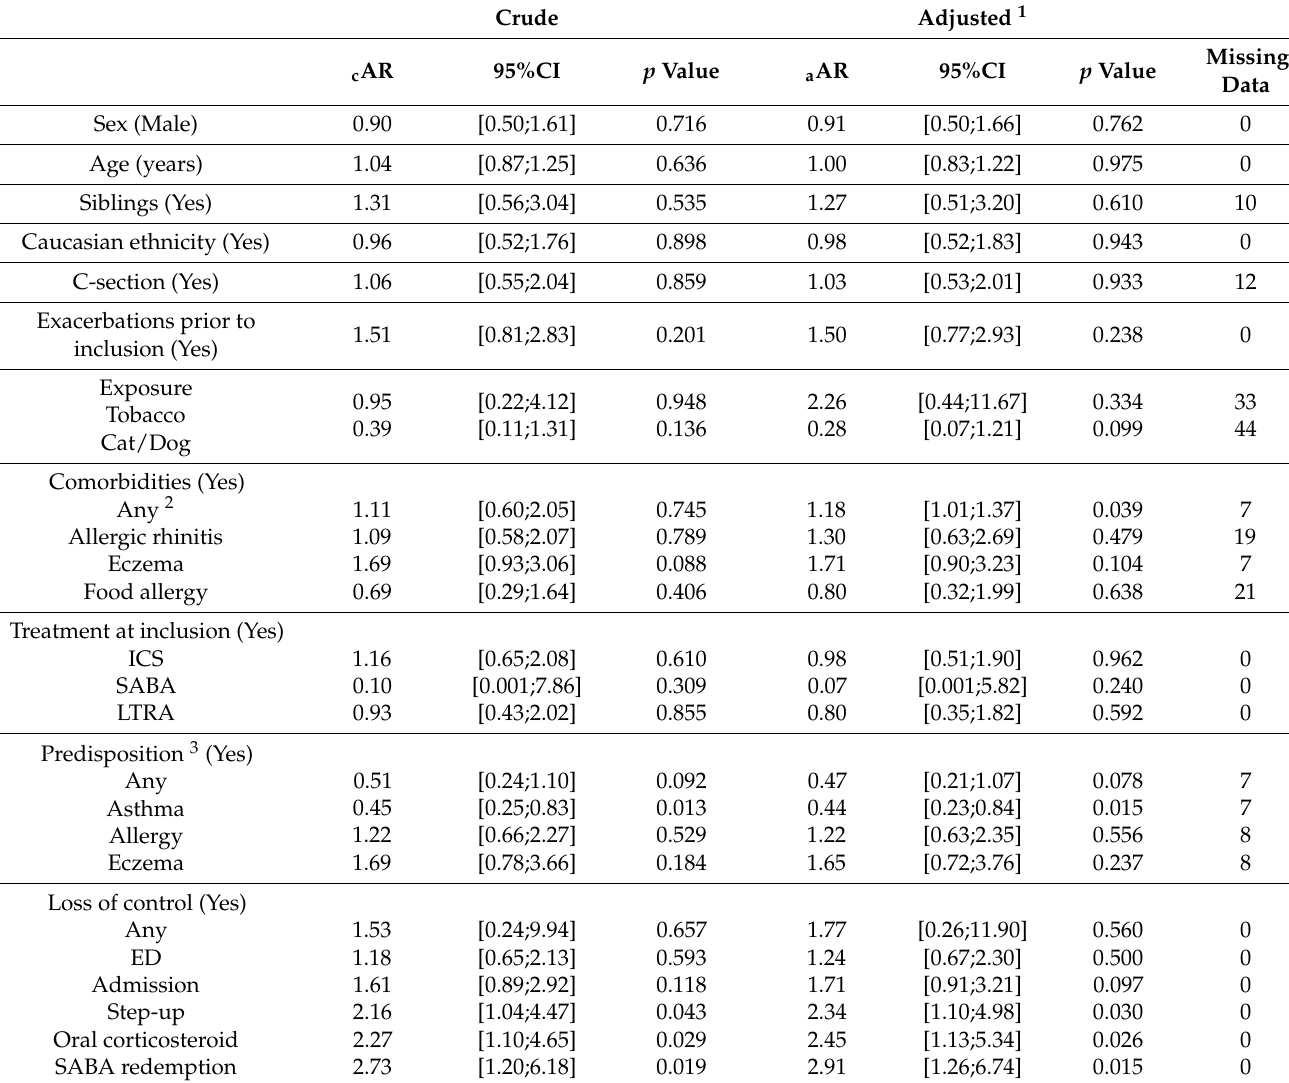
Table 3. Adherence ratio (AR), days with ICS treatment/days without ICS treatment.